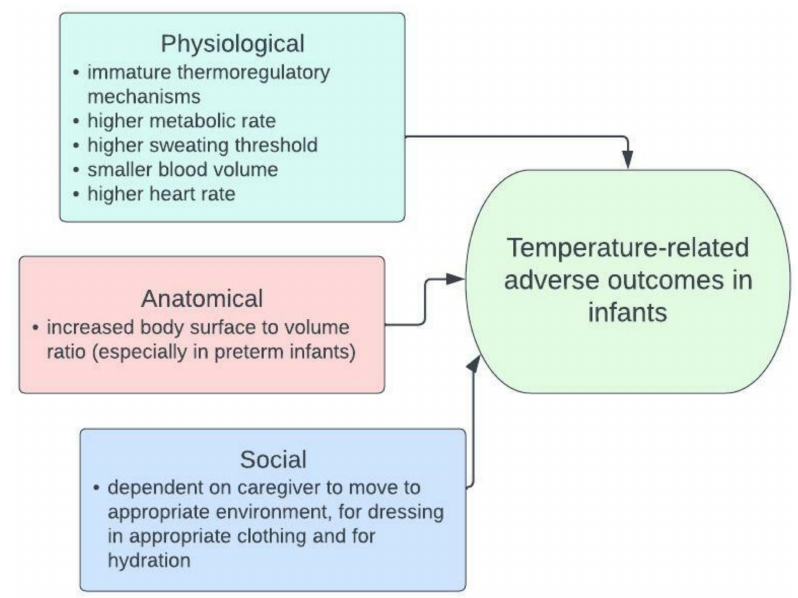
Figure 1. The factors that could increase temperature vulnerability in infants compared to older children and adults